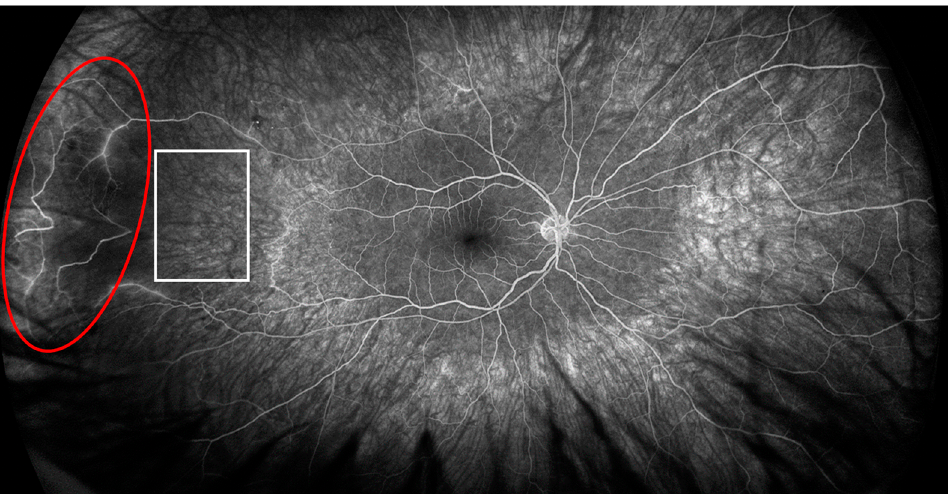
Figure 2. Fluorescein angiography of the right eye showing ischemic area (white square) and area of active vasculitis (red circle).